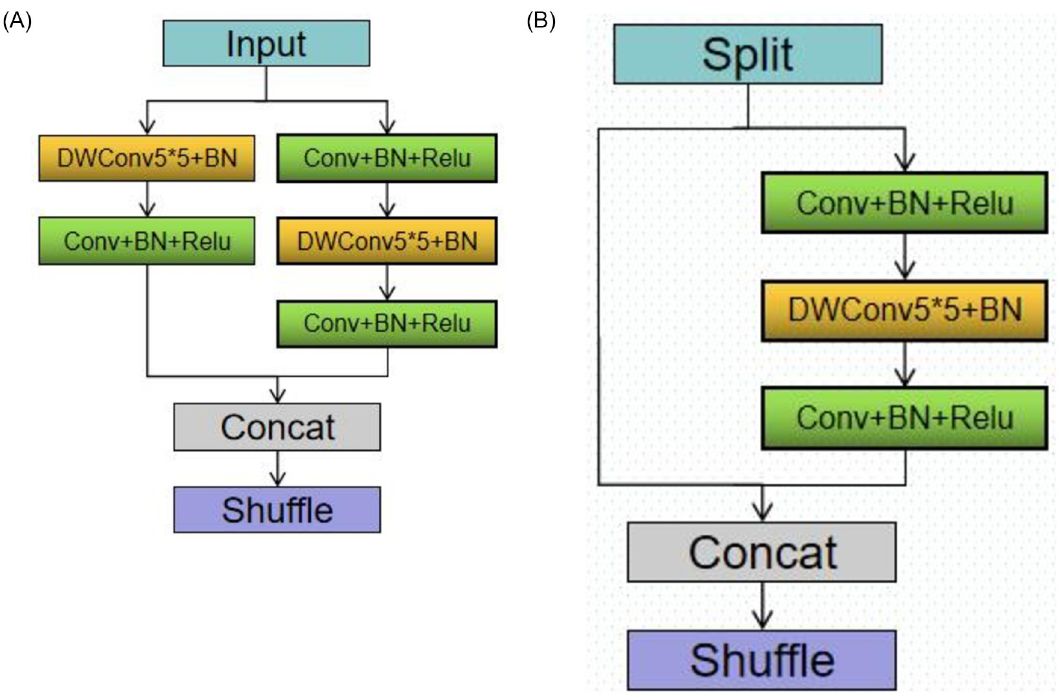
Fig 3. Shufflenet_V2 network main block (a) DownSampling block (b) Normal